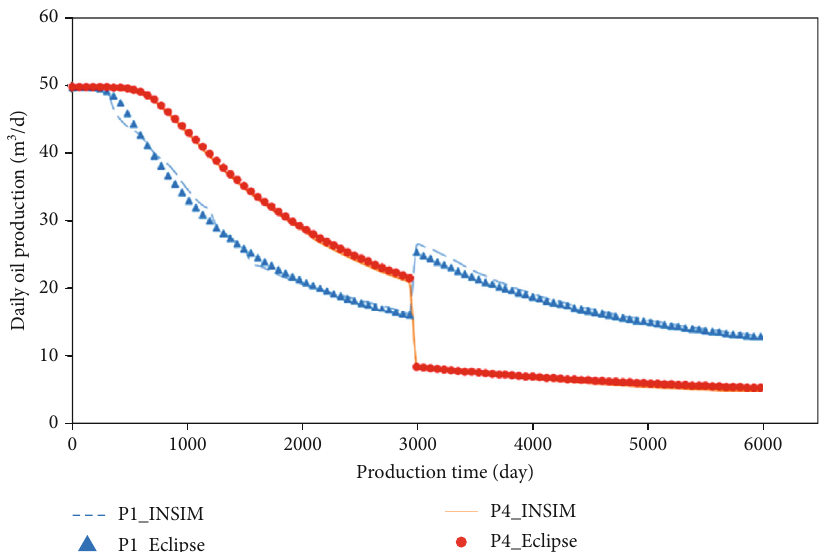
Figure 5: The fi tting e ff ect of daily oil production.